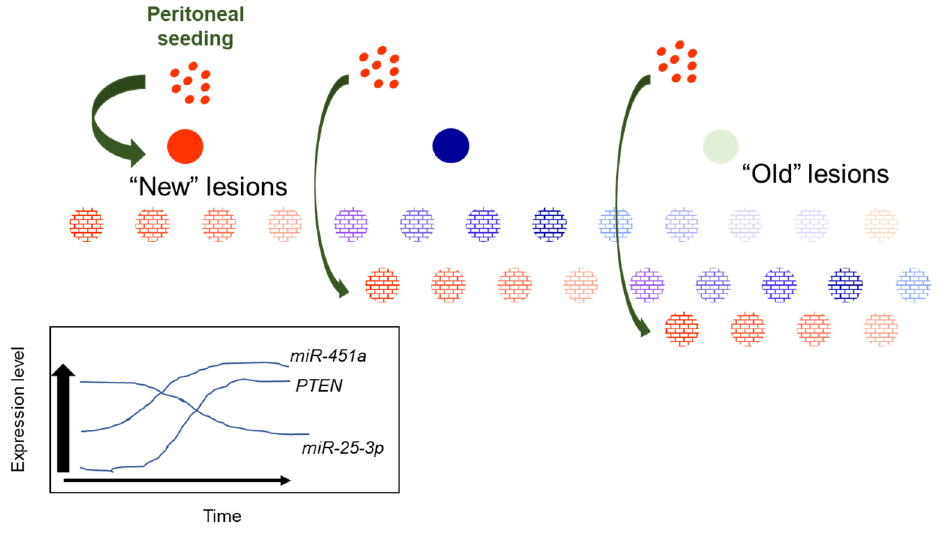
Figure 7. Proposed working model for heterogeneity of miR-451a, miR-25-3p and PTEN expression in red peritoneal lesions as they transition to regression.